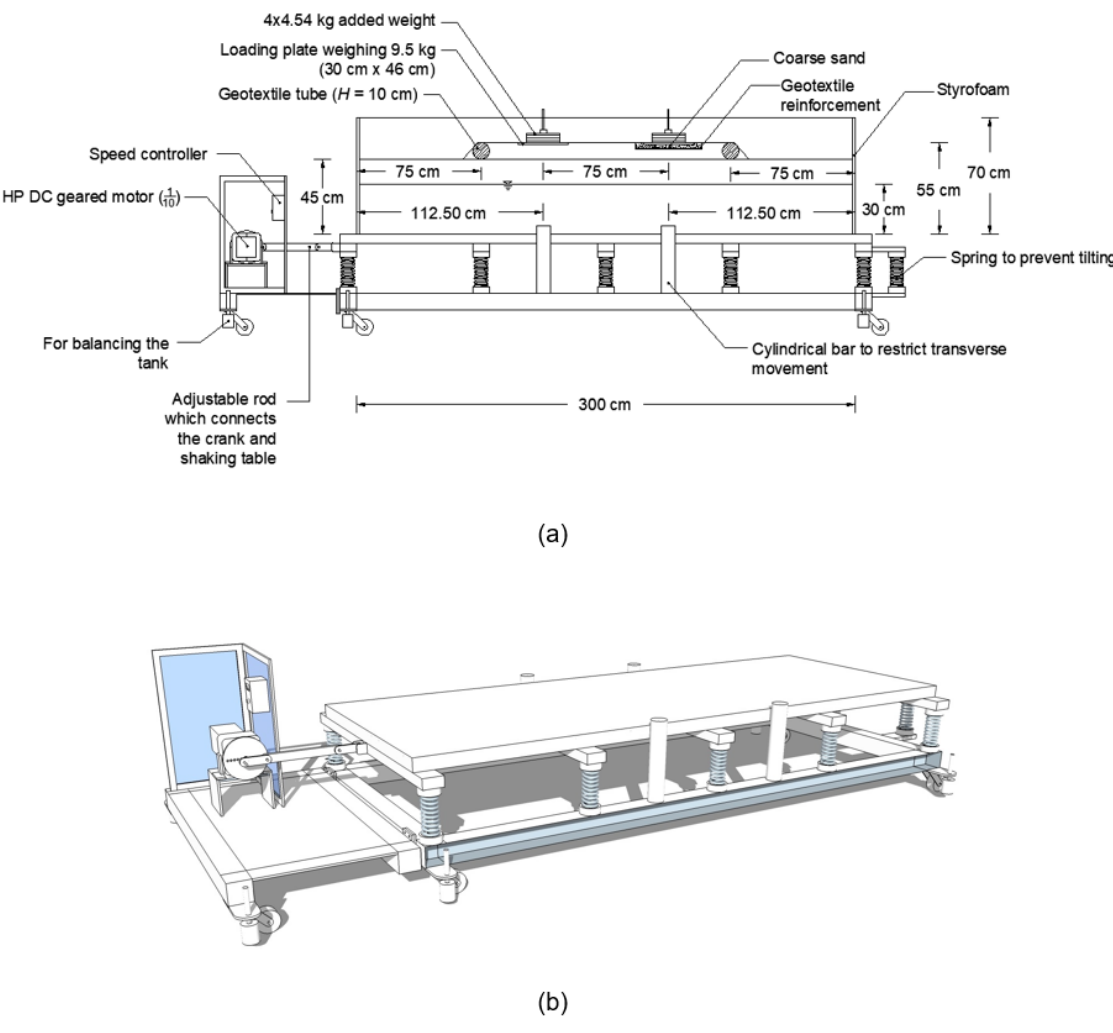
Figure 11. Shaking table test: ( a ) scale model test setup, and ( b ) isometric view of shaking table.